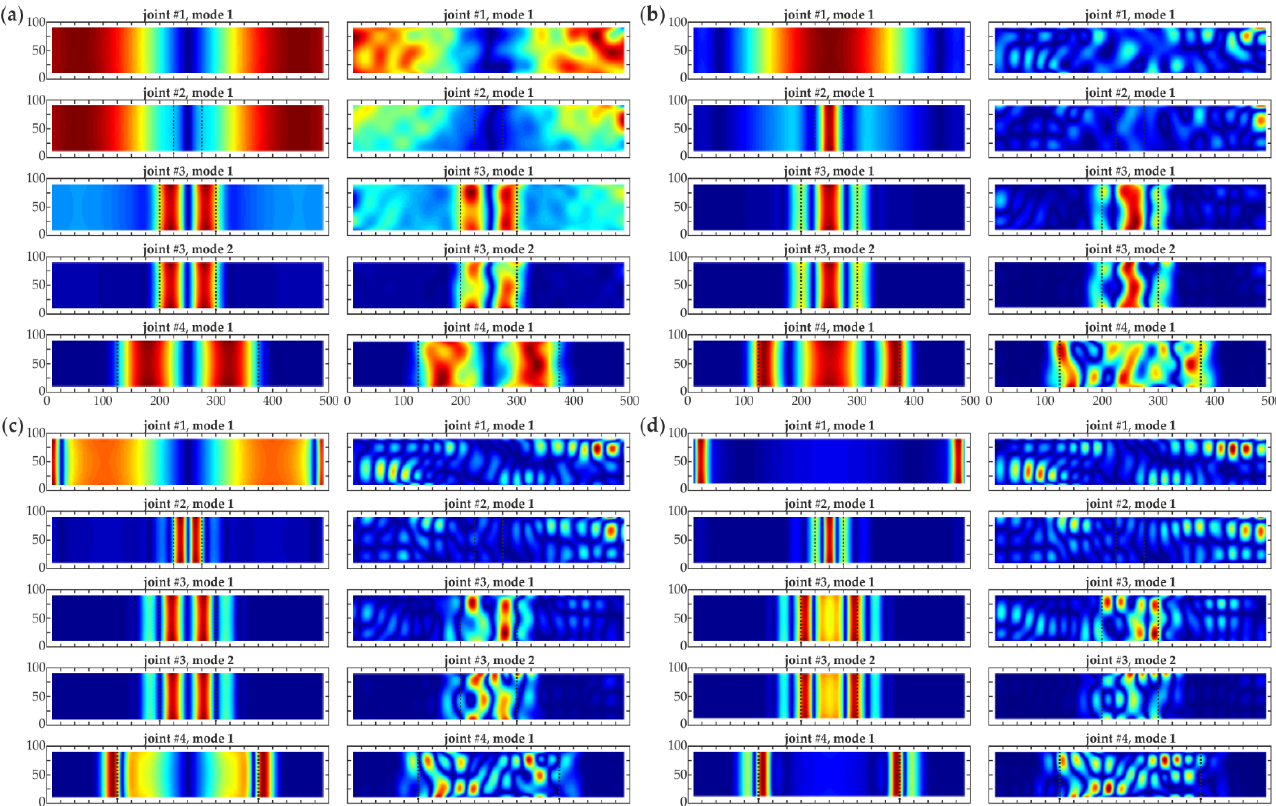
Figure 9. Comparison of CWT damage imaging for numerical (left column) and experimental (right column) results (grid 20 mm interpolated to 2 mm) for all joints #1–#4 (dimensions in [mm], scale s = 8) using different wavelets: ( a ) gaus1 ; ( b ) gaus2 ; ( c ) gaus3 ; ( d ) gaus4 .